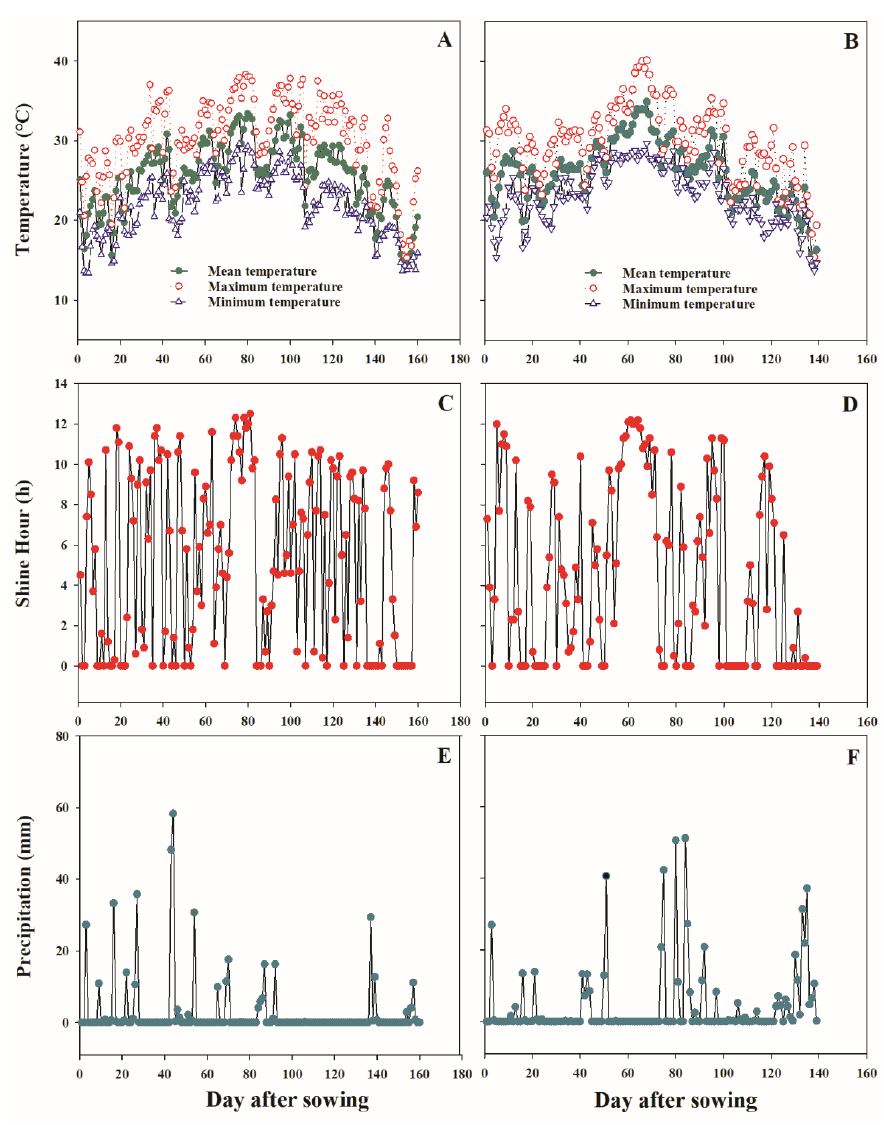
Figure 1. Air temperature, sunshine hours, and precipitation during the rice growing season in ( A , C , E ) and 2017 ( B , D , F 2016 ( A , C , E ) and 2017 ( B , D , F ).